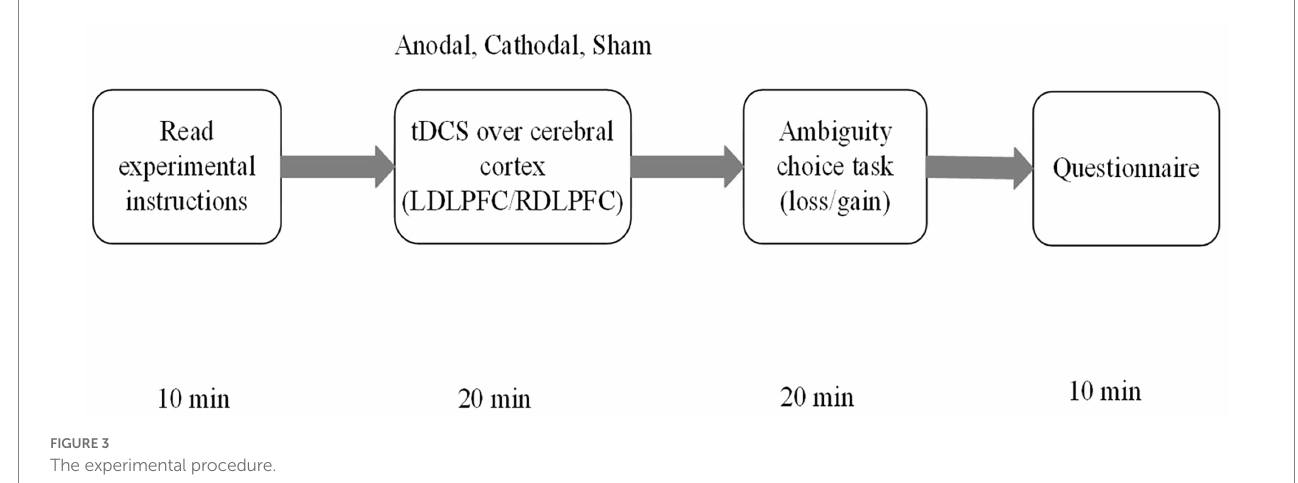
FIGURE 3 The experimental procedure.